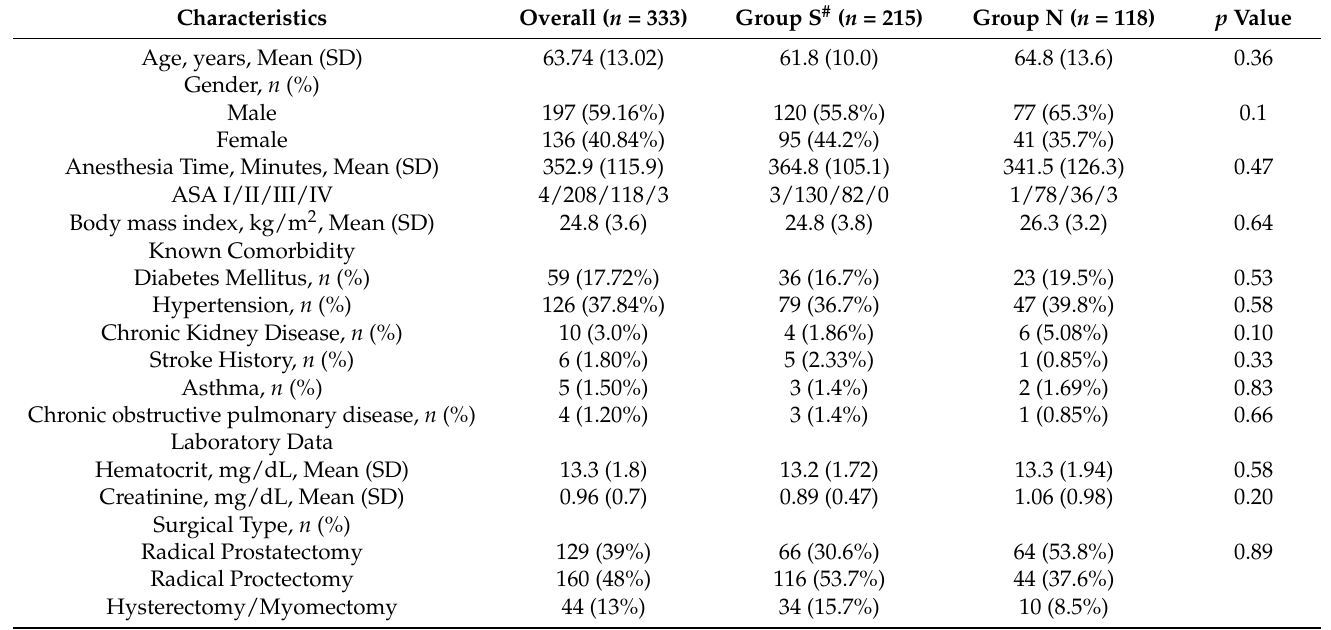
Table 2. Patient characteristics.